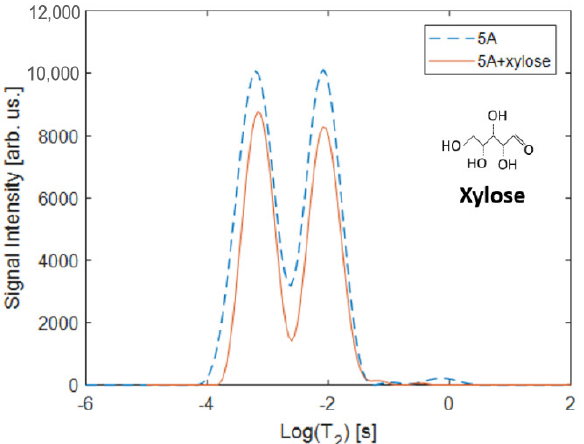
Figure 1. T 2 distributions comparing the core zeolite Grace 5A beads before and after the addition of 20% wt. xylose to the water permeating through the system. In the 5A beads with water there are two large populations at T 2 = 6.193 × 10 − 4 s and 8.300 × 10 − 3 s and a small population at longer T 2 = 0.806 s. The presence of xylose eliminates the longer relaxation component and slightly shifts the two dominant populations to slightly longer relaxation times T 2 = 7.518 × 10 −4 s and 9.100 × 10 −3 s. The 20% wt. xylose in water solution has a large relaxation population at T 2 = 1.167 s and a small population at 1.260 × 10 −1 s representing the biopolymer and water relaxation times (not shown). The chemical structure of xylose is shown in the upper right.